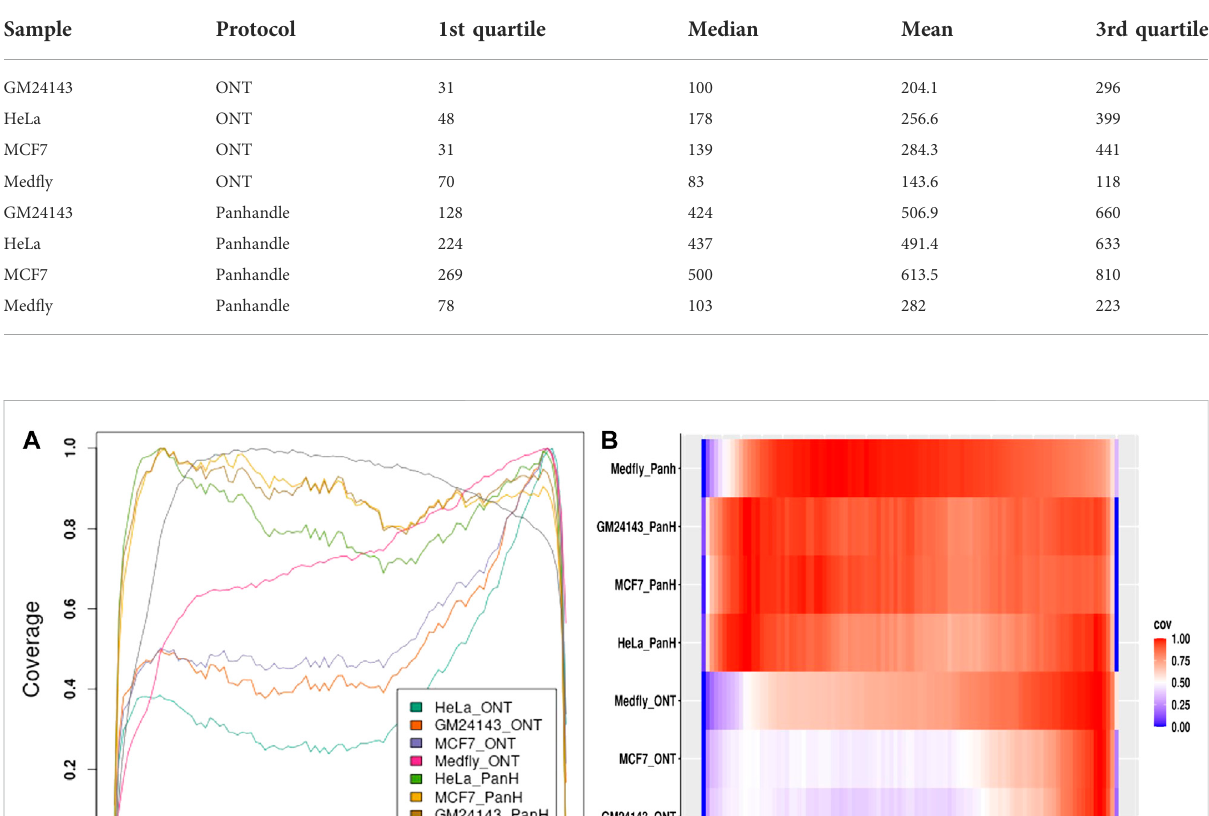
protocol (207 vs. 37, 454 vs. 139, 537 vs. 248, and 701 vs. 379, respectively, Table 4).